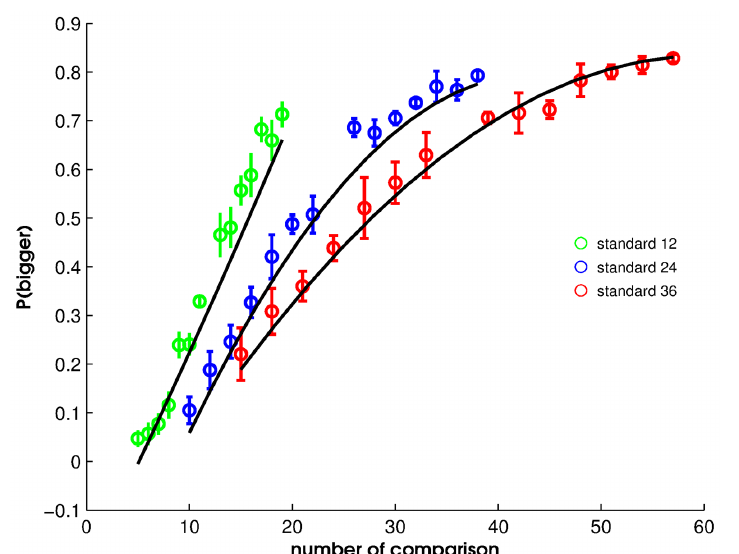
Figure 3. Psychometric functions showing the probability of answering 'bigger' as a function of the numerosity of the target and of the standard stimulus. On the x-axis is reported the number of dots of the target stimulus. Error bars are standard errors of the mean.